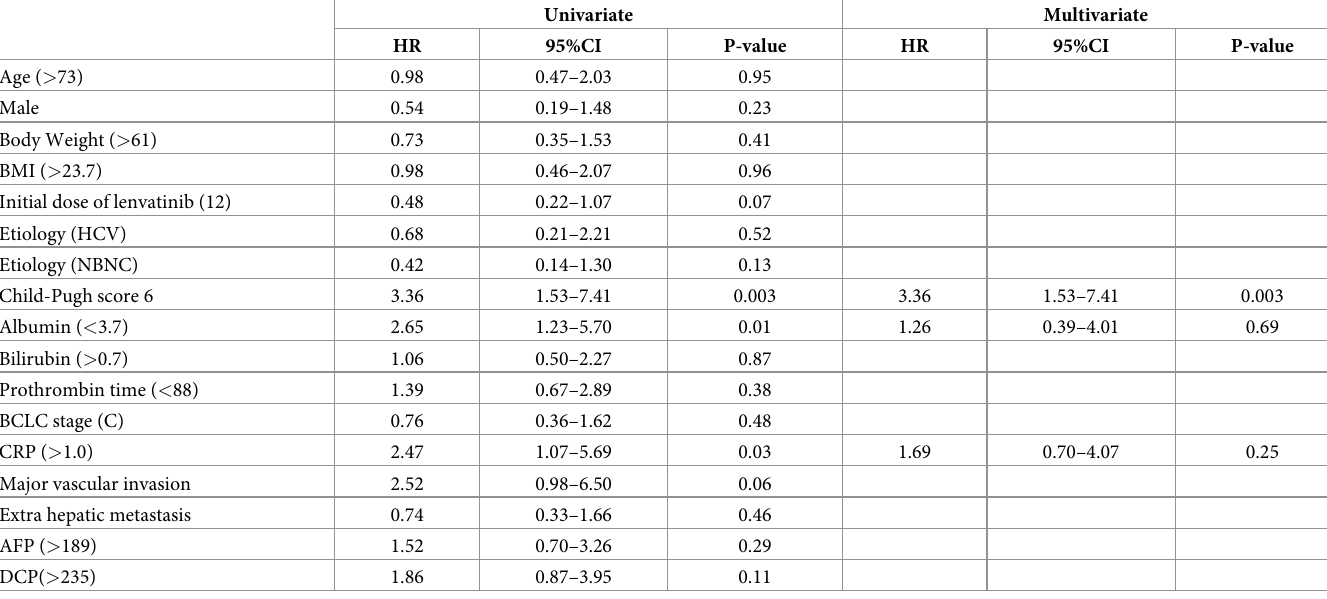
Fig 4. Time to progression (TTP) in high and low CRP groups. Median TTPs in high CRP group (dotted line) and low CRP group (solid line) were 83 and 156 days, respectively (log-rank test; p = 0.03). https://doi.org/10.1371/journal.pone.0244370.g004 groups stratified by baseline Child-Pugh score 5 and 6 (Fig 5). In patients with a Child-Pugh score of 5 points, time to decompensation in the high and low CRP groups were not different (100% vs 46.5%/ 1year, p = 0.17). In those with a Child-Pugh score of 6, time to decompensa- tion in the high and low CRP groups were not different (70.4% vs 100%/ 1year, p = 0.22). Cumulative incidence of liver related events in two groups were stratified by Child-Pugh score 5 and 6. In patients with a Child-Pugh score of 5 points, time to liver related events in Table 4. Univariate and multivariate analysis to determine the factors associated with